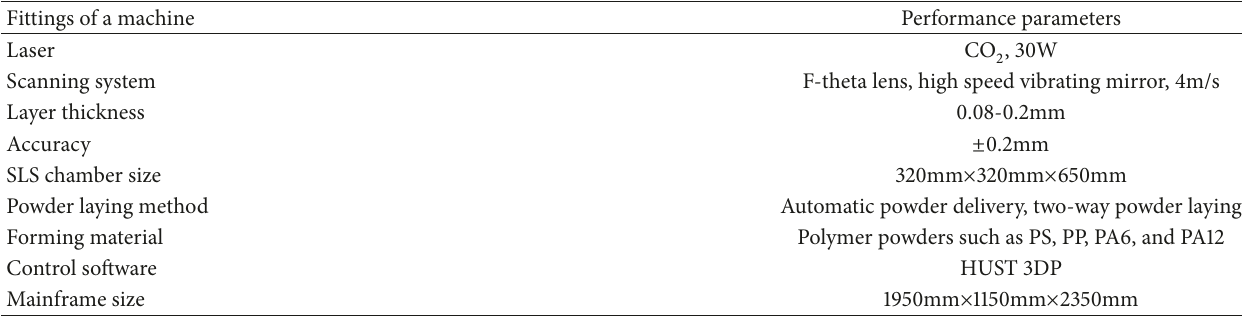
Table 2: Performance parameters of HK P320 laser sintering